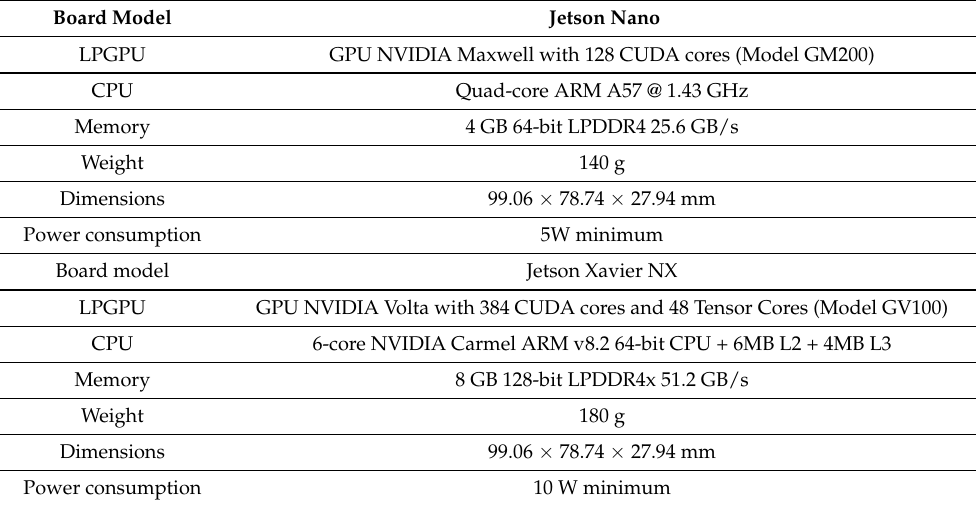
Table 2. Technical specifications of the NVIDIA Jetson Nano and NVIDIA Jetson Xavier NX.